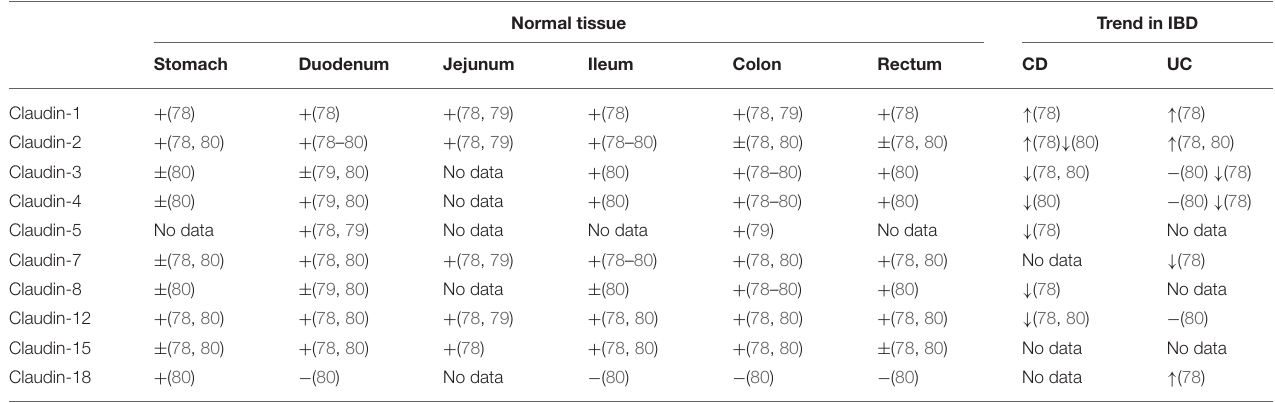
TABLE 2 | Expression patterns of claudins in normal human tissue in comparison with altered expression in IBD. Normal tissue Trend in IBD Stomach Duodenum Jejunum Ileum Colon Rectum